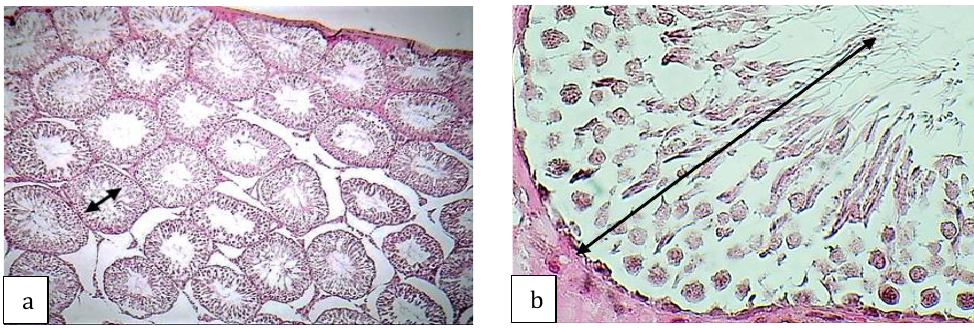
Figure 1. A photomicrograph of the right testis of an adult male Wistar rat in control group showing a) normal architecture of seminiferous tubules with no lesions (arrow), b) typical spermatogenesis phases (arrow) including normal spermatogonia, spermatocytes, spermatids, and spermatozoa (H&E,